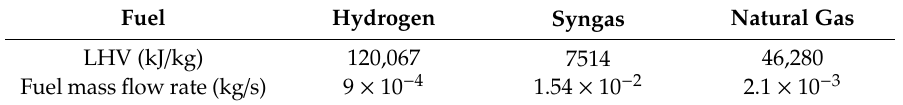
Table 4. Lower Heating Value (LHV) and daily average mass flow rates for the three fuels considered.